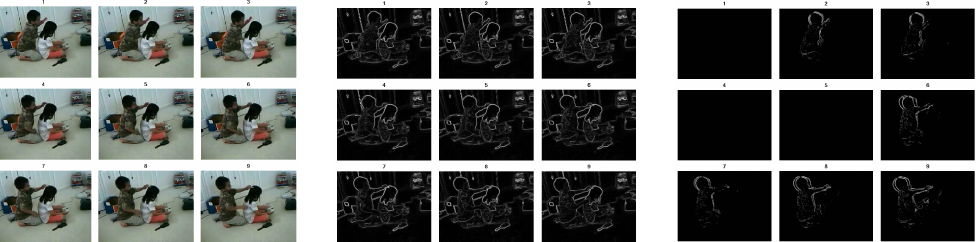
Figure 3. ( Left ): nine consecutive frames of a video; ( center ): the gradient of each frame; ( right ): the absolute value of the difference between the gradient of each frame and the next frame.